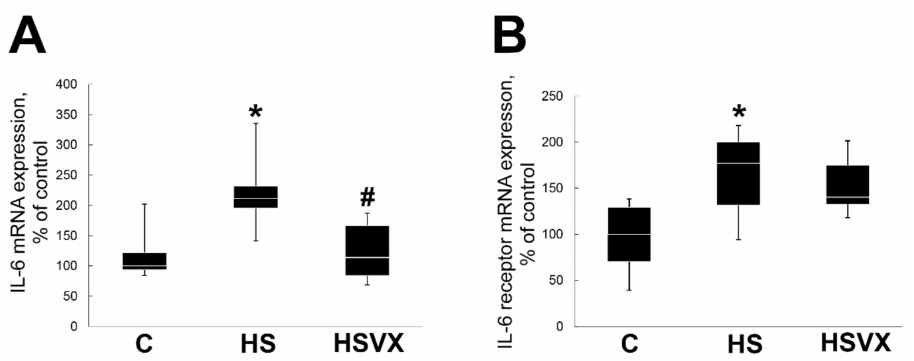
Figure 7. Evaluation of mRNA expression of IL-6 ( A ) and IL-6 receptor ( B ) in soleus muscles of C, HS, and HSVX rats. Values are normalized to the level of GAPDH mRNA in each sample. n = 8. * indicates a significant difference from the control, p < 0.05; # indicates a significant difference from the HS, p <